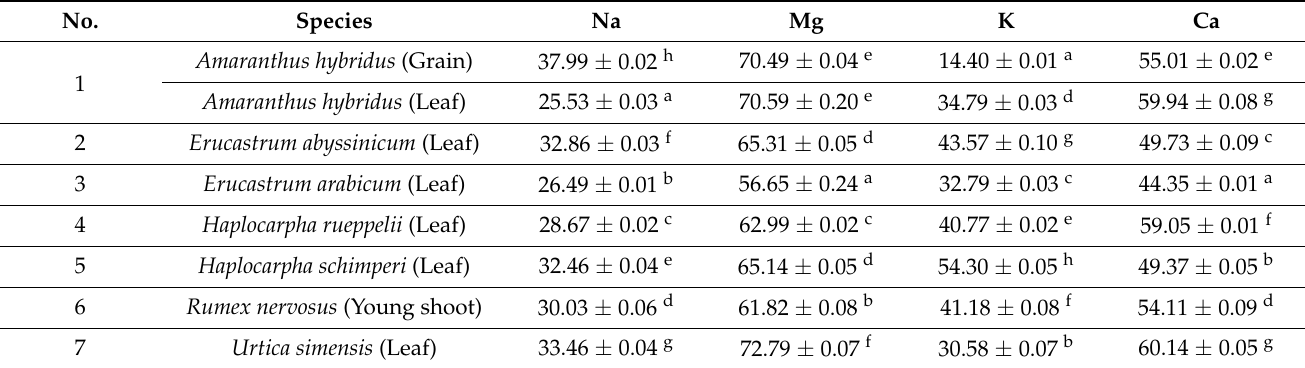
Table 2. Macronutrient contents of selected wild edible plants (mg/100 g